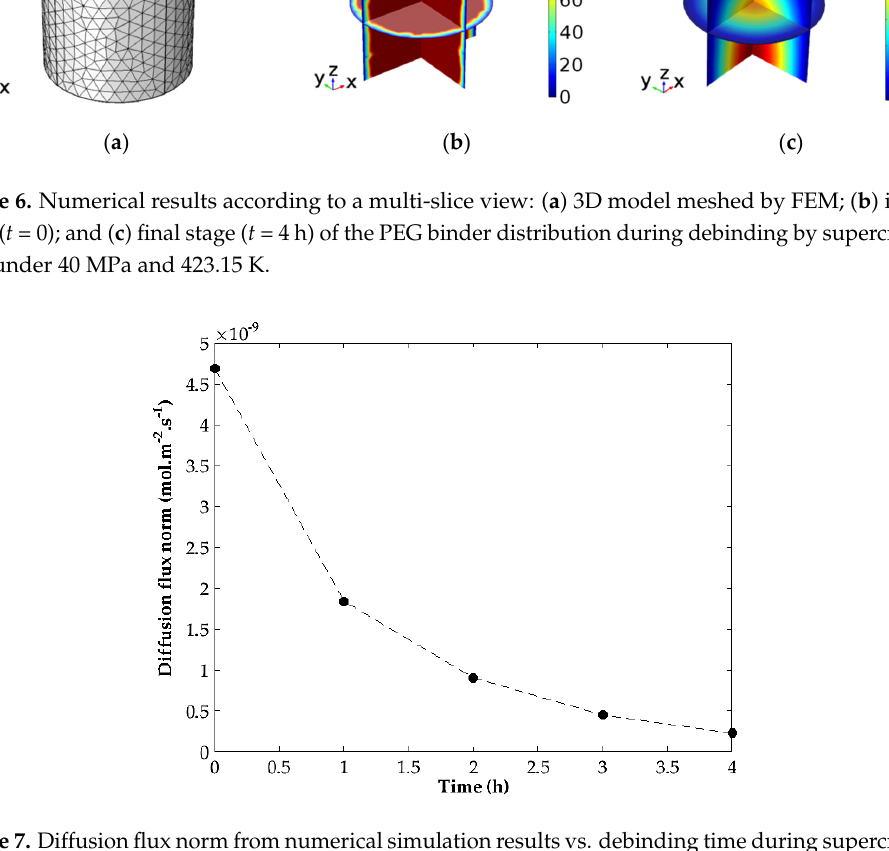
Figure 7. Diffusion flux norm from numerical simulation results vs. debinding time during supercritical CO 2 under 40 MPa and 423.15 K.